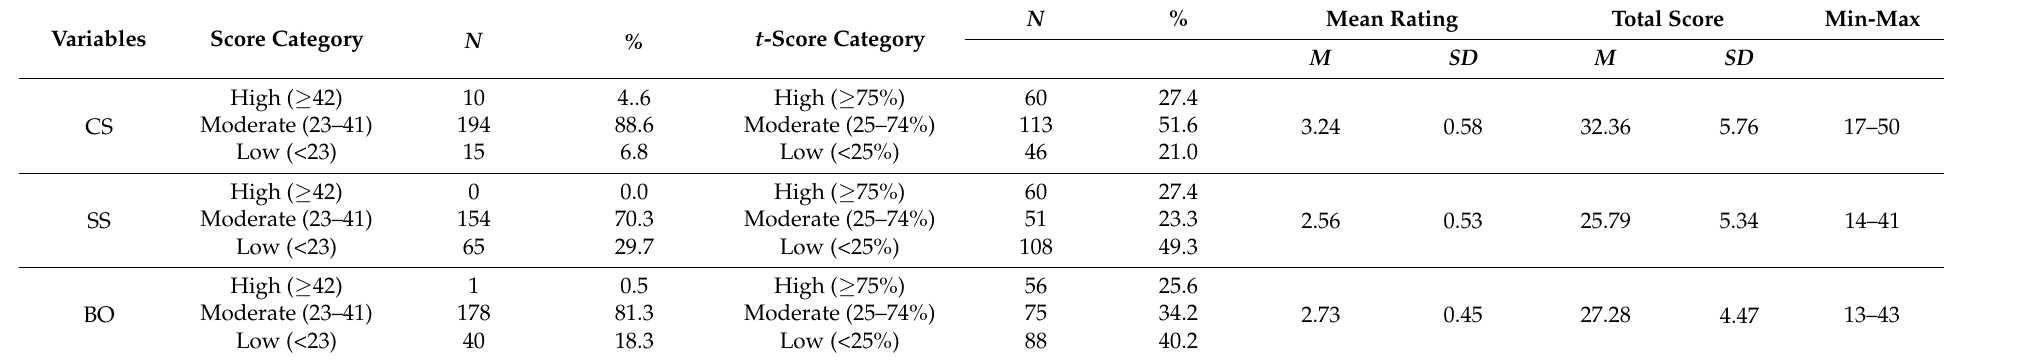
Table 3. Degree of compassion satisfaction, secondary traumatic stress, and burnout (N =